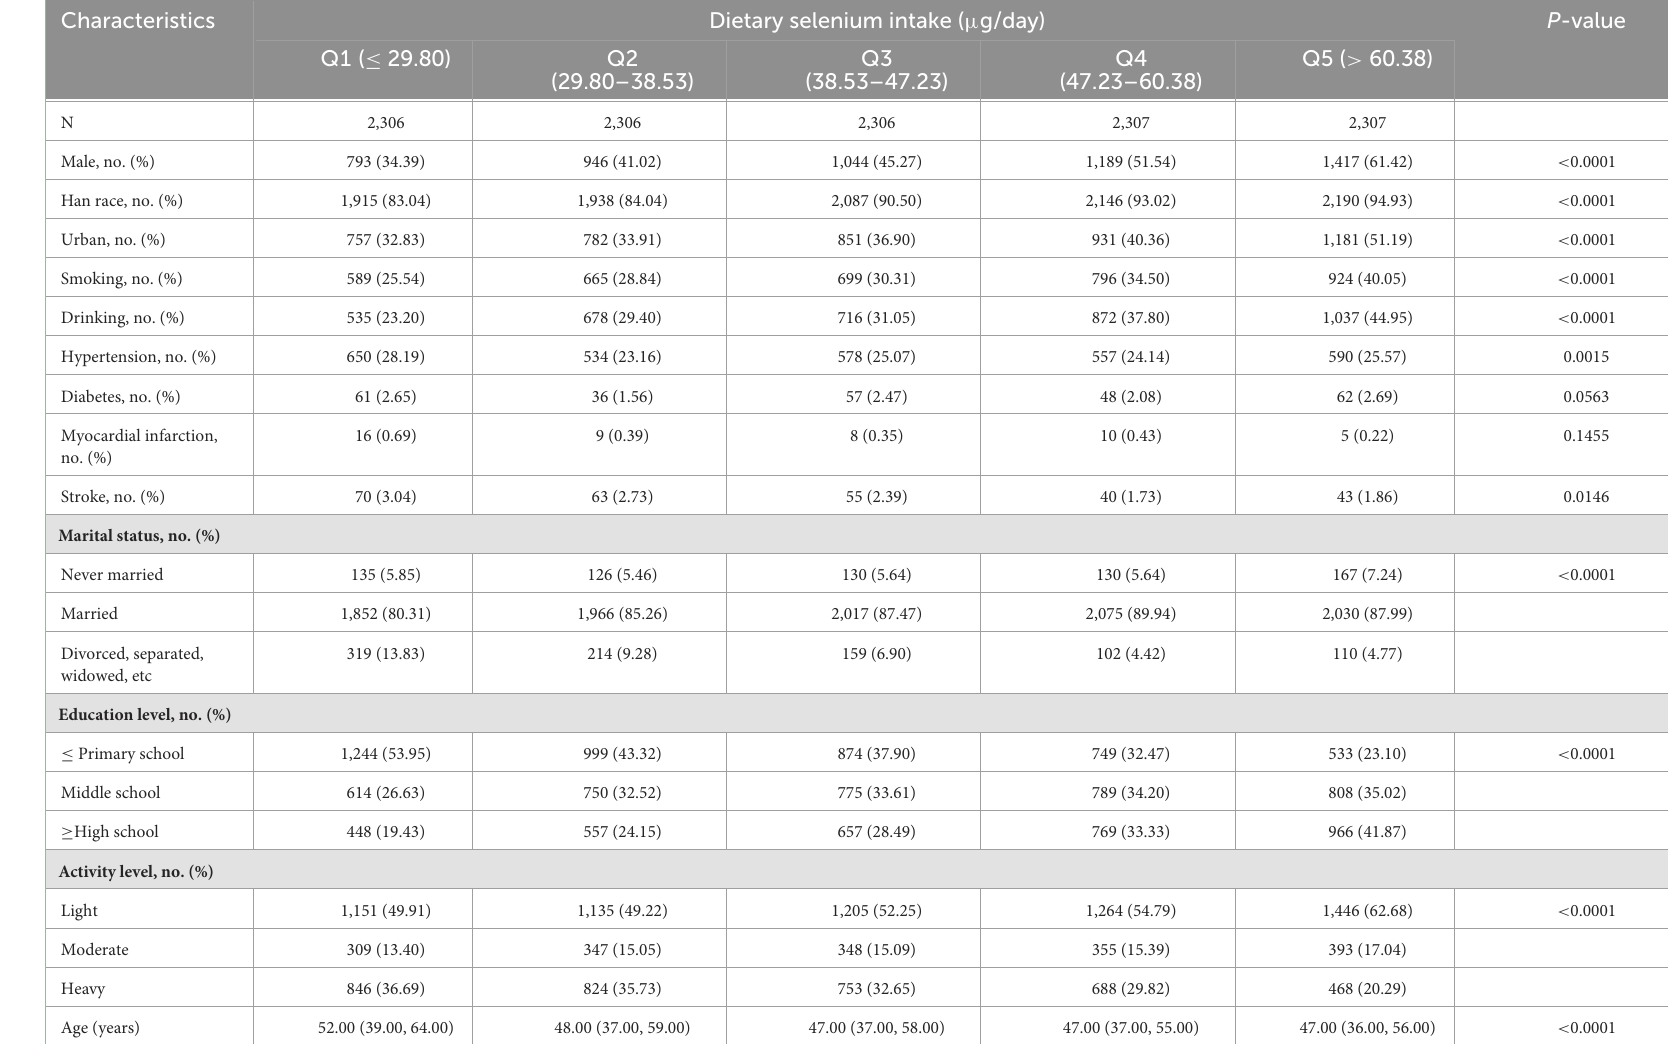
TABLE 2 Baseline characteristics of participants according to quintiles of dietary selenium intake.